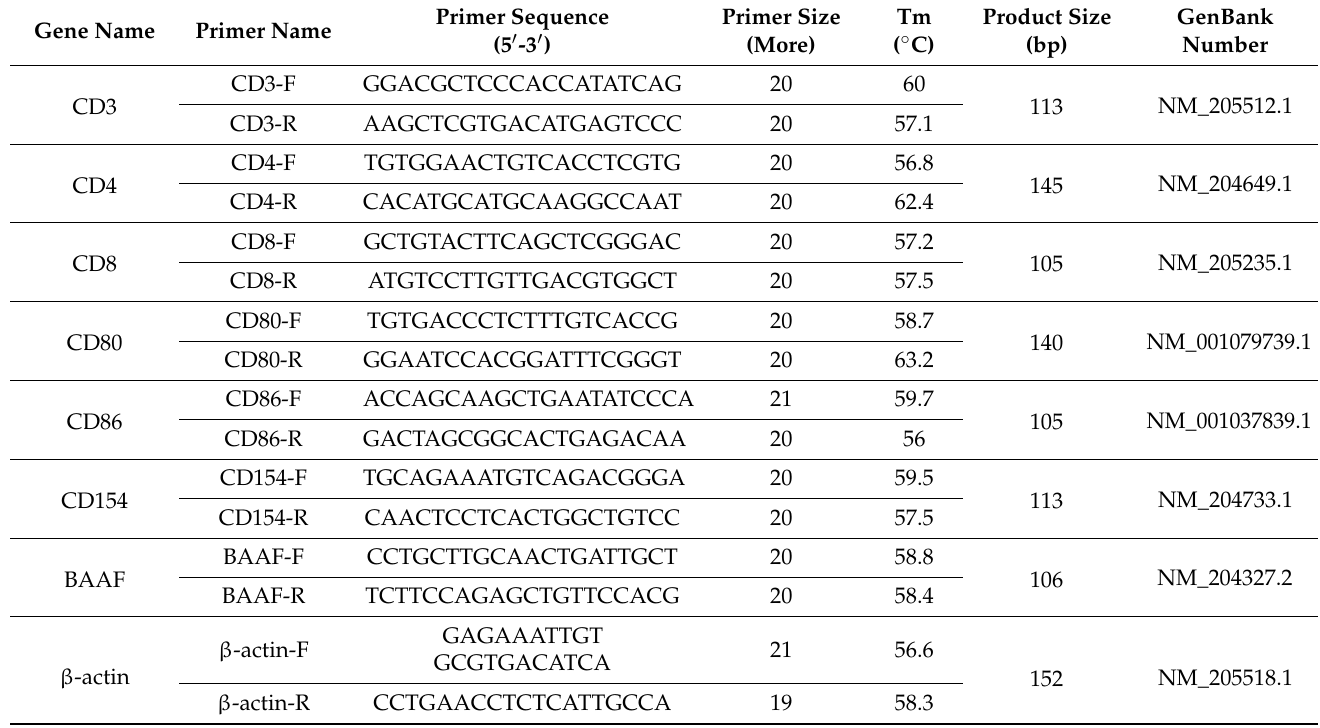
Table 4. Primers used to detect the molecules in chicken spleen